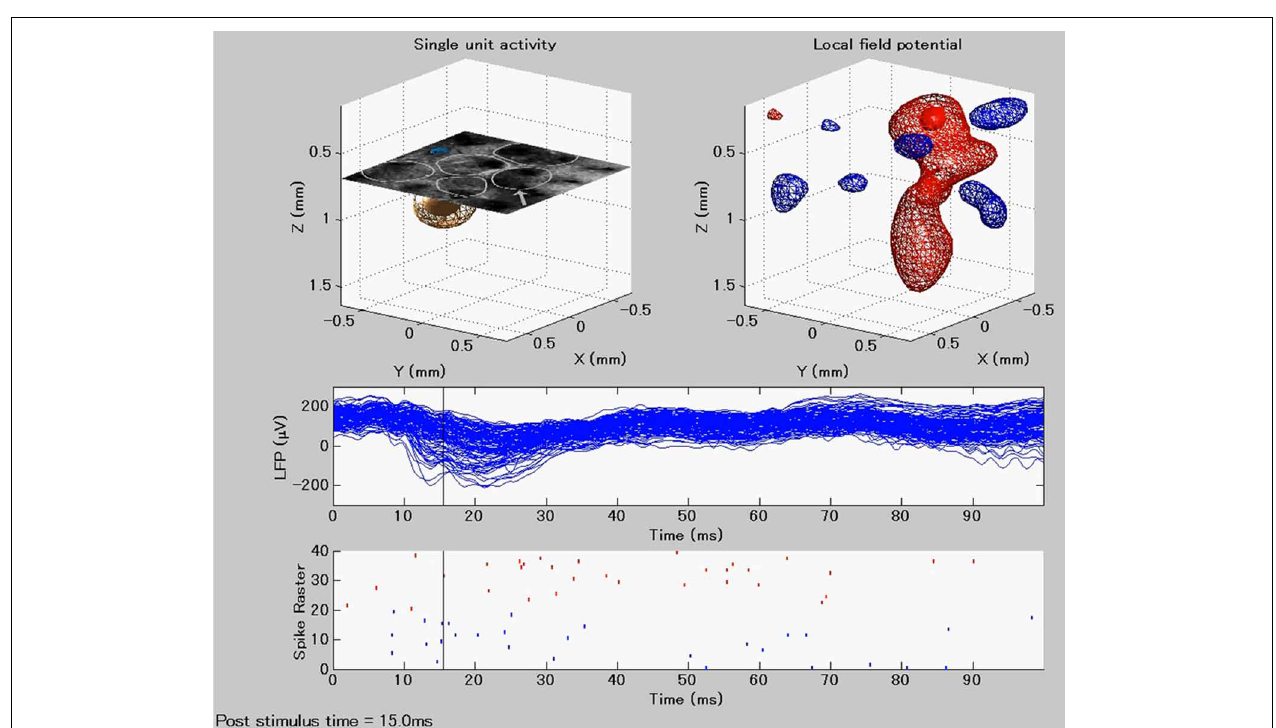
respectively. Blue and green are for the current sources generated by PC/SS and IN, respectively. In the right panel , red and blue are used to represent current sink and source, respectively. The CSD maps were estimated from instantaneous ERPs at 8ms post-stimulus time of a single whisker deflection. On the right frame, the white circles in the histological image denotes the barrels and one of them, indicated by the arrow, corresponds to the barrel associated to the deflected whisker in this particular condition.